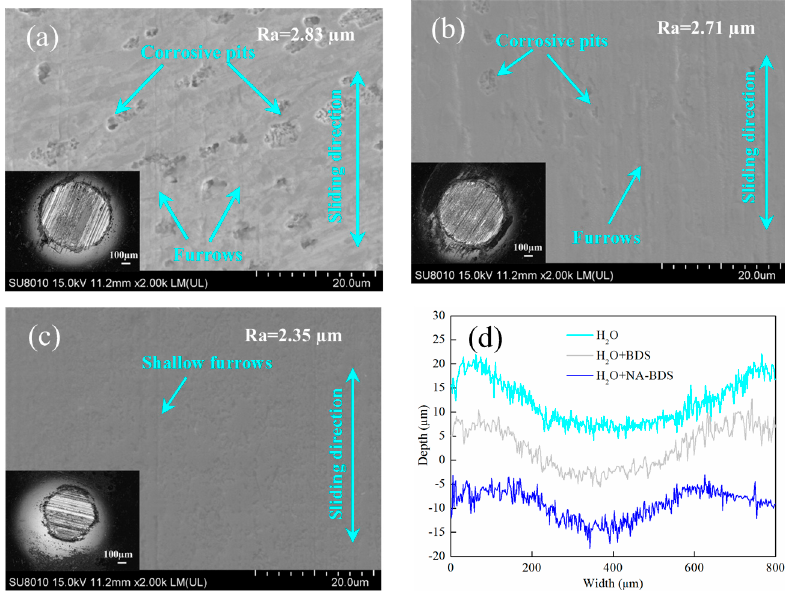
Figure 8. Field-emission scanning electron microscopy (FESEM) images and optical micrographs of wear scars on upper balls lubricated using ( a ) H 2 O, ( b ) H 2 O + BDS, and ( c ) H 2 O + NA-BDS. ( d ) Corresponding worn surface profiles (soot content = 0.2 wt %, load = 100 N, speed = 50 mm/s, duration = 30 min).